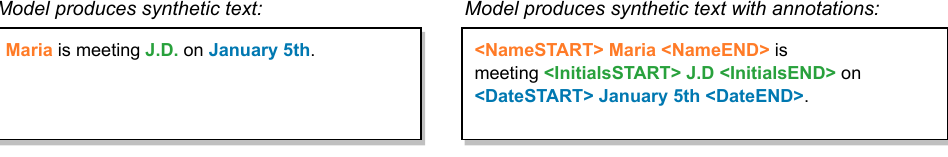
Figure 1. Illustrative example comparing standard text generation with the approach taken in this paper. We introduce special tokens to delimit protected health information (PHI). These tokens can be learned and generated like any other token by the language models. A prompt of three tokens defines the initial context.